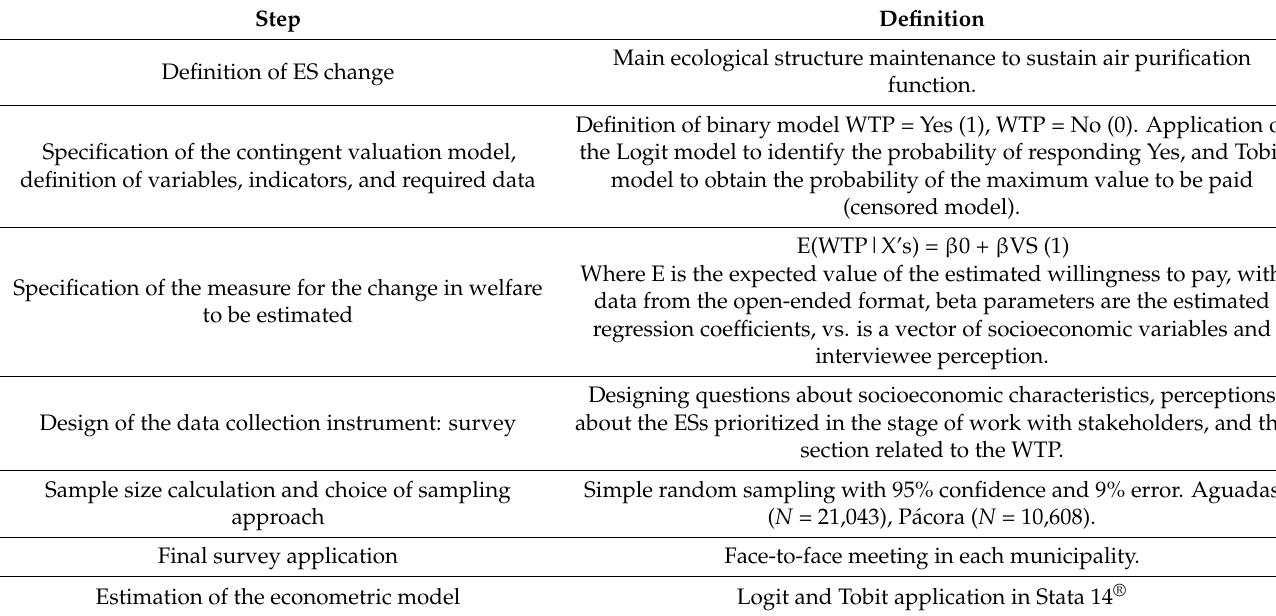
Table 1. Summary of the contingent valuation methodological